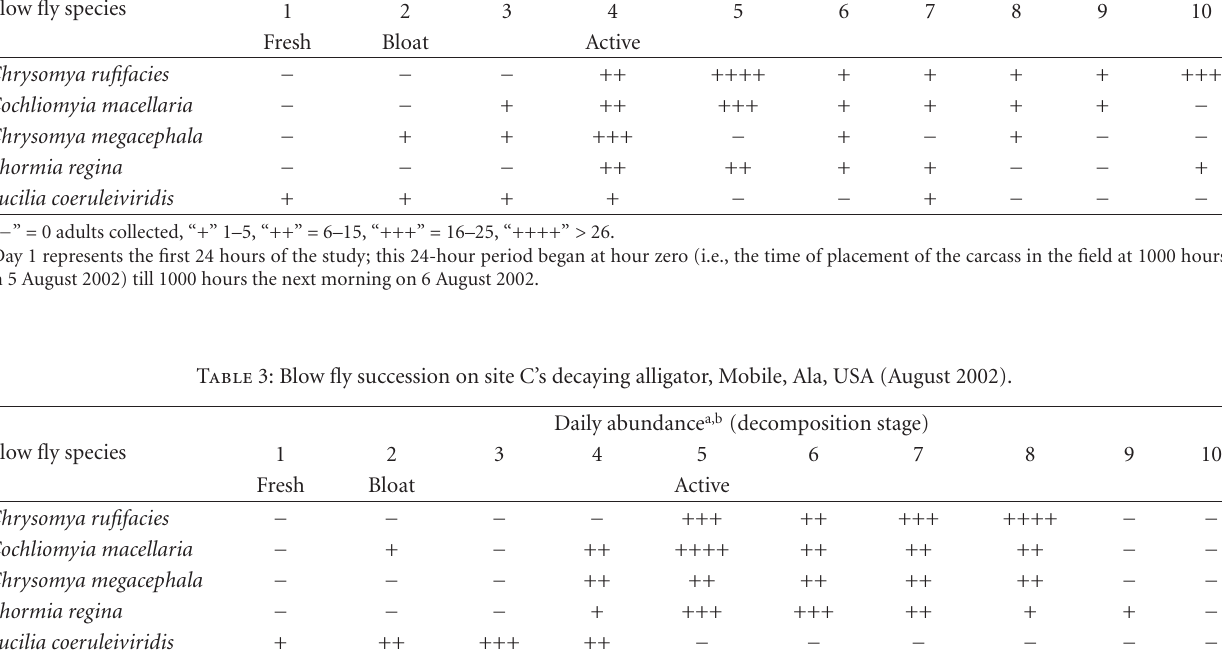
Table 2: Blow fly succession on site B’s decaying alligator, Mobile, Ala, USA (August 2002). Blow fly species